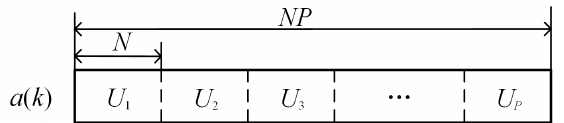
Figure 3. The known local UW structure.